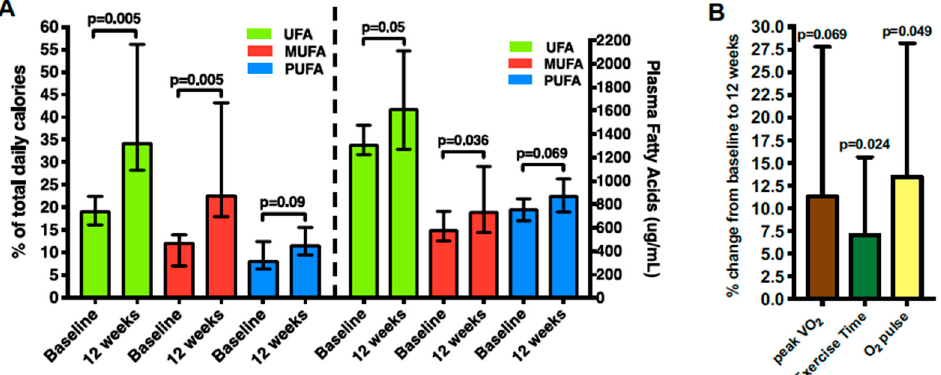
Figure 2. ( A ) Demonstrates increases from baseline to 12-week follow-up in UFA, MUFA, and PUFA expressed in percent total daily calories, as well as plasma fatty acids ( µ g / mL) in nine HFpEF subjects who supplemented dietary UFA daily for 12 weeks as part of the UFA-Preserved pilot trial. ( B ) Demonstrates trend towards increase in Peak VO 2 (mL / kg / min), exercise time, and O 2 pulse (mL / beat) from baseline to 12-week follow-up in the UFA-Preserved pilot trial. Used with permission by Carbone et al. [89]. UFA, unsaturated fatty acids; MUFA, monounsaturated fatty acids; PUFA, polyunsaturated fatty acids; Peak VO 2 , peak oxygen consumption; O 2 , oxygen.